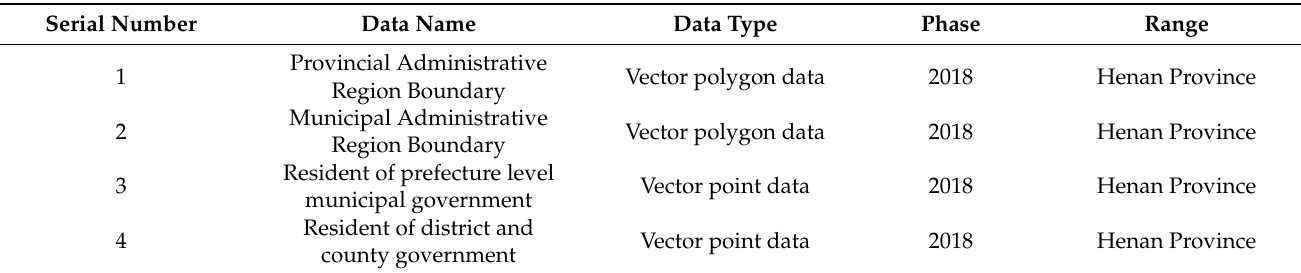
Table 2. Geographic auxiliary data used in this